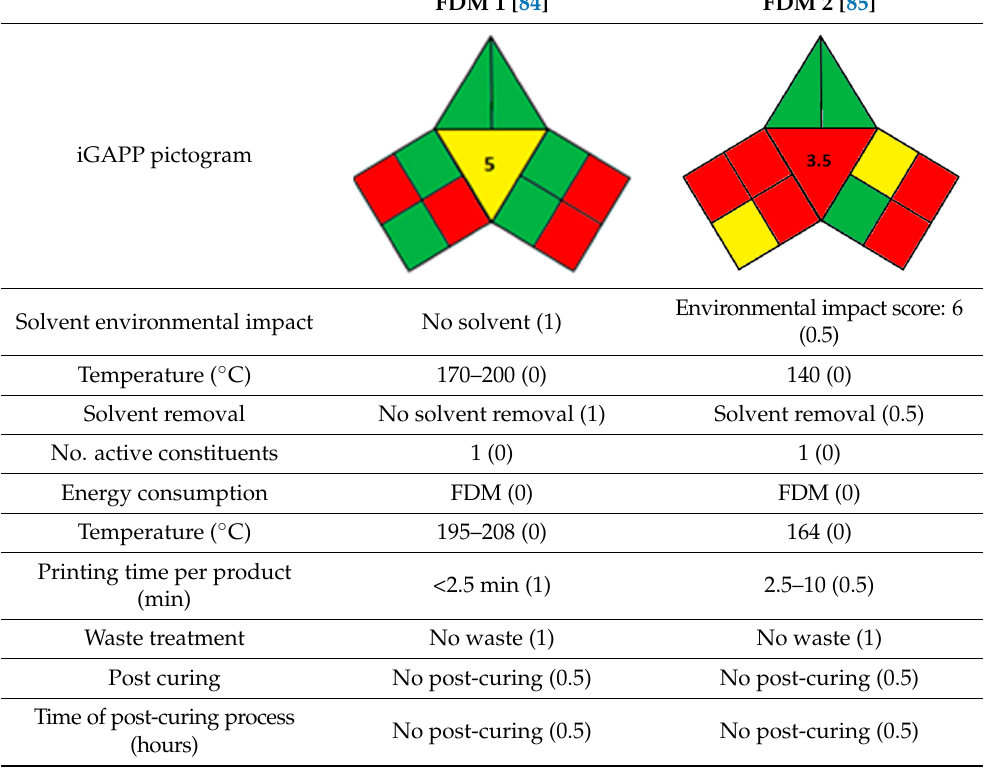
Table 5. Comparative greenness evaluation of two reported SSE methods.